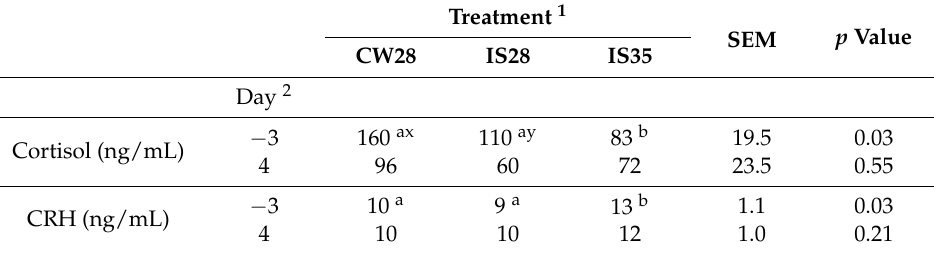
Table 4. Effect of intermittent suckling with and without an older weaning age on cortisol and corticotrophin releasing hormone (CRH) concentrations (ng/mL) of piglets before and after